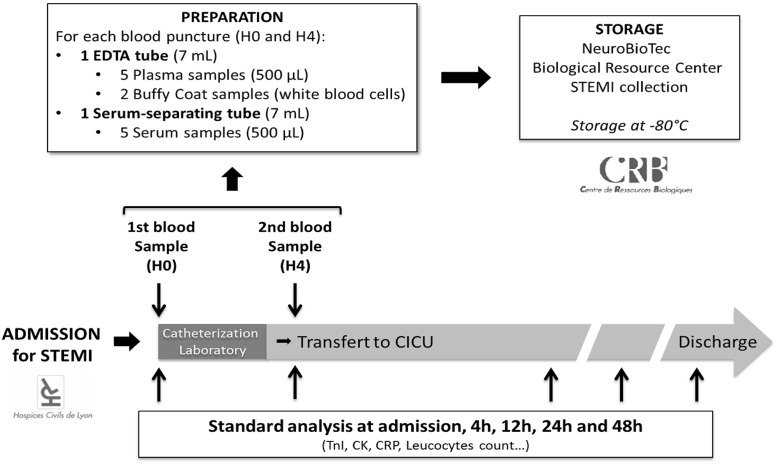
Blood samples collection protocol for STEMI cohort at our institution.